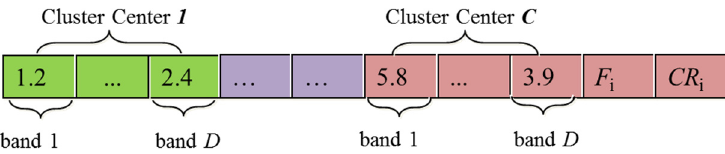
Figure 7. The example of individual encoding in jDE (e.g., K cluster centers and two